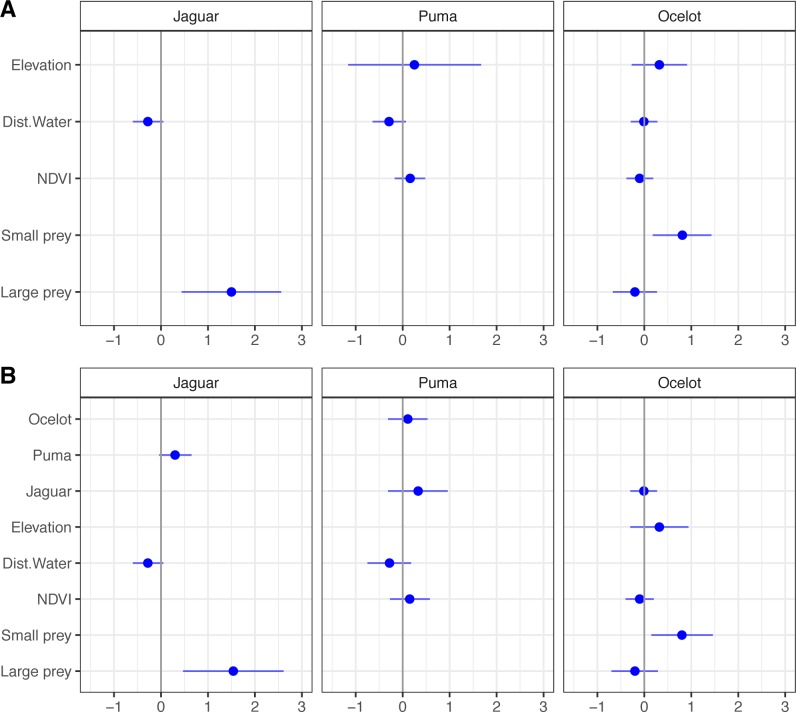
Covariates effect on habitat use of jaguar, puma and ocelot.Beta estimates with 95% of confidence interval estimated from single-season species models: row A—Beta estimates from occupancy models to assess habitat factors; row B–Beta estimates from occupancy models to assess both habitat factors and species interactions (The beta estimates has an effect on the dependent variable when confidence interval do not include 0).